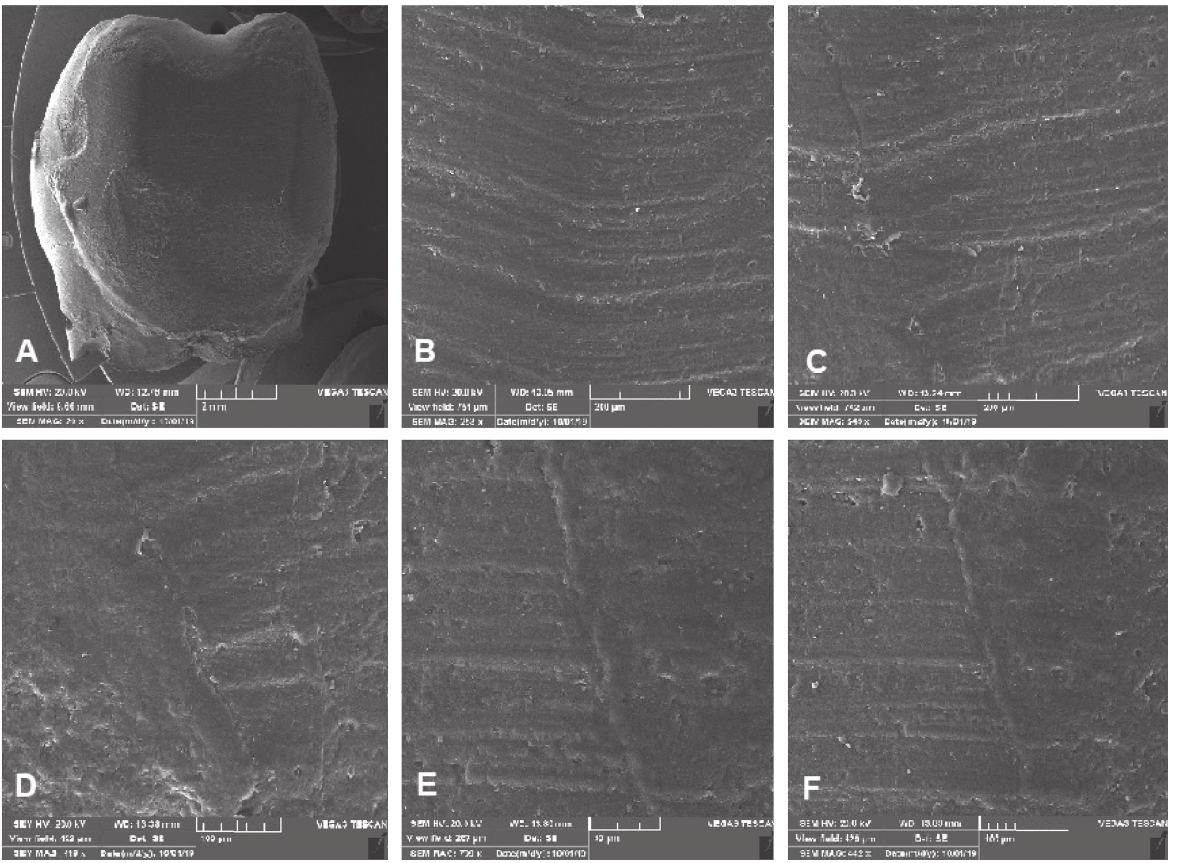
Figure 1: SEM images of the cavity-restoration interface at each gingival margin of the extensive restoration. (a) 20x, (b) 253x, (c) 249x, (d) 419x, (e) 709x, and (f)